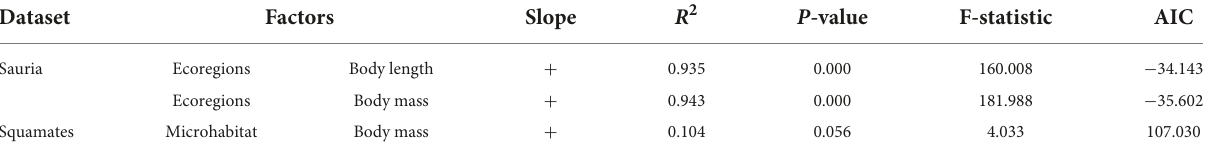
TABLE 7 Association analyses between phenotypes and ecological